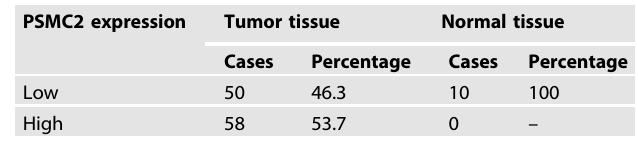
Fig. 1 PSMC2 was upregulated in HCC tissues and expressed in HCC cells. A The PSMC2 expression was evaluated by IHC analysis in HCC tissues and normal tissues (scale bar = 50 μ m). B The mRNA expression of PSMC2 in normal cell line HL-7702 and HCC cell lines including HCCLM3, SK-HEP-1, BEL-7404, SNU423, and Hep3B2.1-7 was determined by qPCR. The representative images were selected from at least three independent experiments. Data were shown as mean ± SD. ** P < 0.01, *** P < 0.001. Table 1. Expression patterns of PSMC2 in HCC tissues and normal tissues revealed in immunohistochemistry